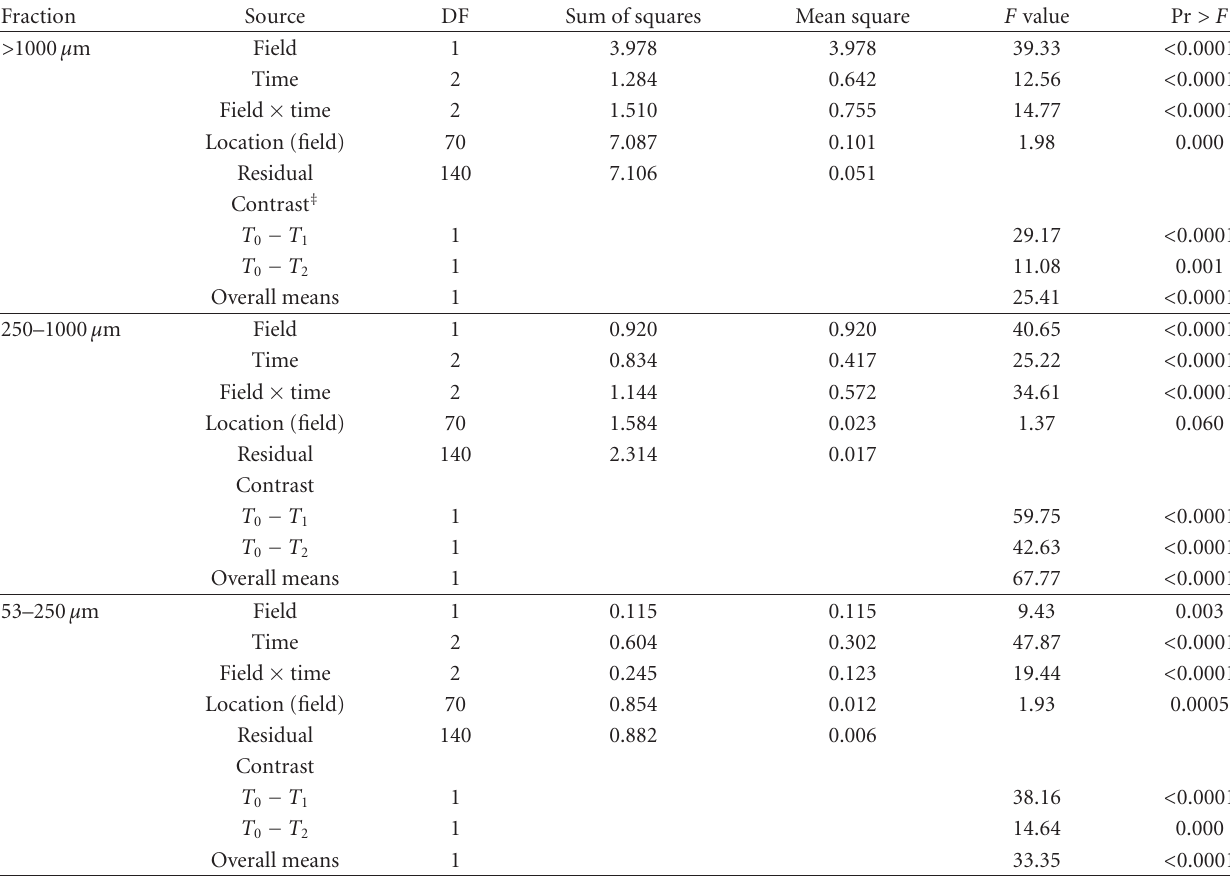
Table 4: E ff ect of standard tillage and no-till on particulate organic matter (POM)-N (BACI † analysis). All the POM-N fractions were log transformed.